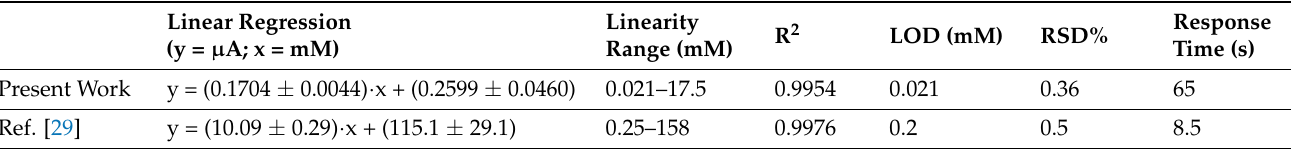
Table 1. Best analytical data of the Clark-type LDH-catalase enzyme biosensor in its lifetime (2nd day). Comparison with data of direct amperometric GC biosensor.